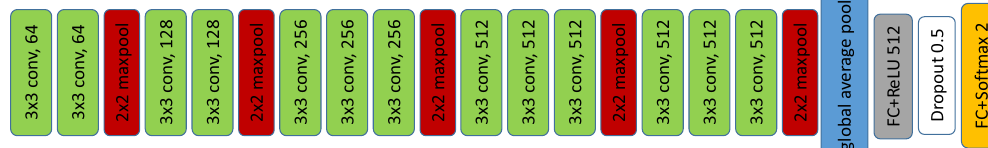
Figure 3. Architecture of the deep convolutional neural network (DCNN) used in this study, which is based on